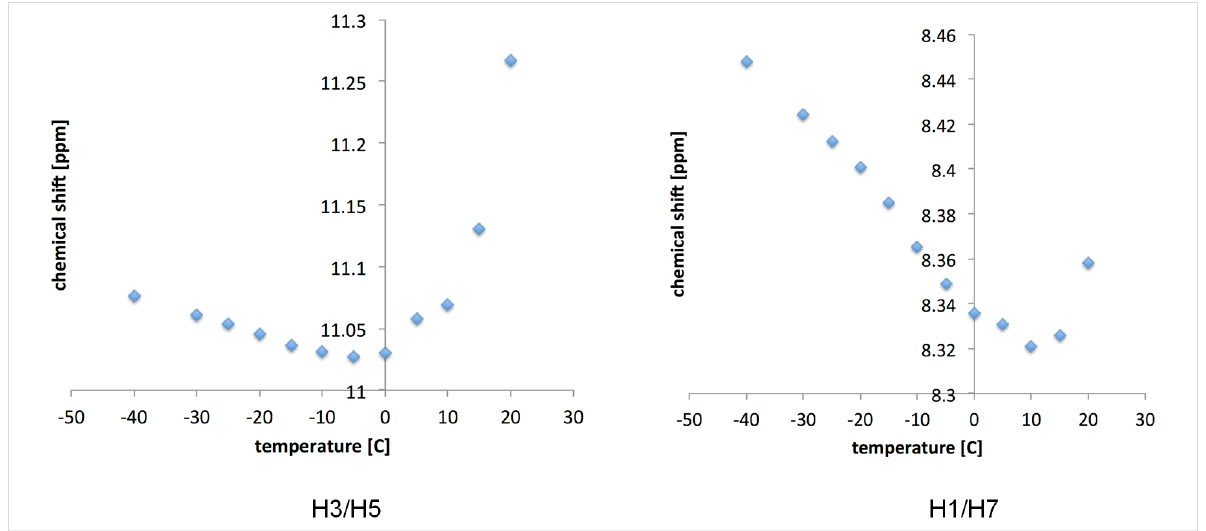
Figure 8: The variable temperature (+20 to − 40 °C, CDCl 3 ) dependence of the main signals (the highest integral values) in 1d ∙∙∙ 5 complex.